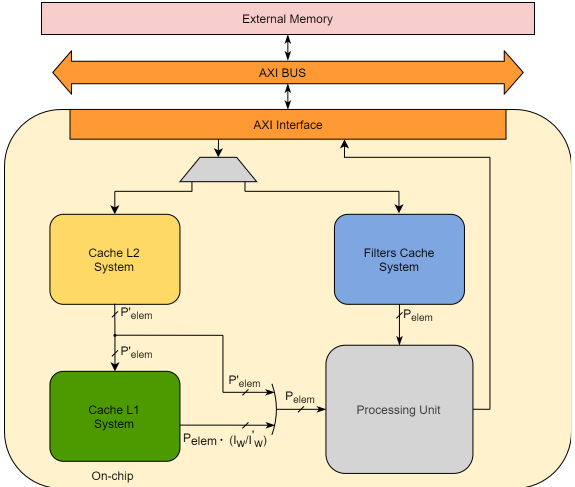
Figure 2. Accelerator block